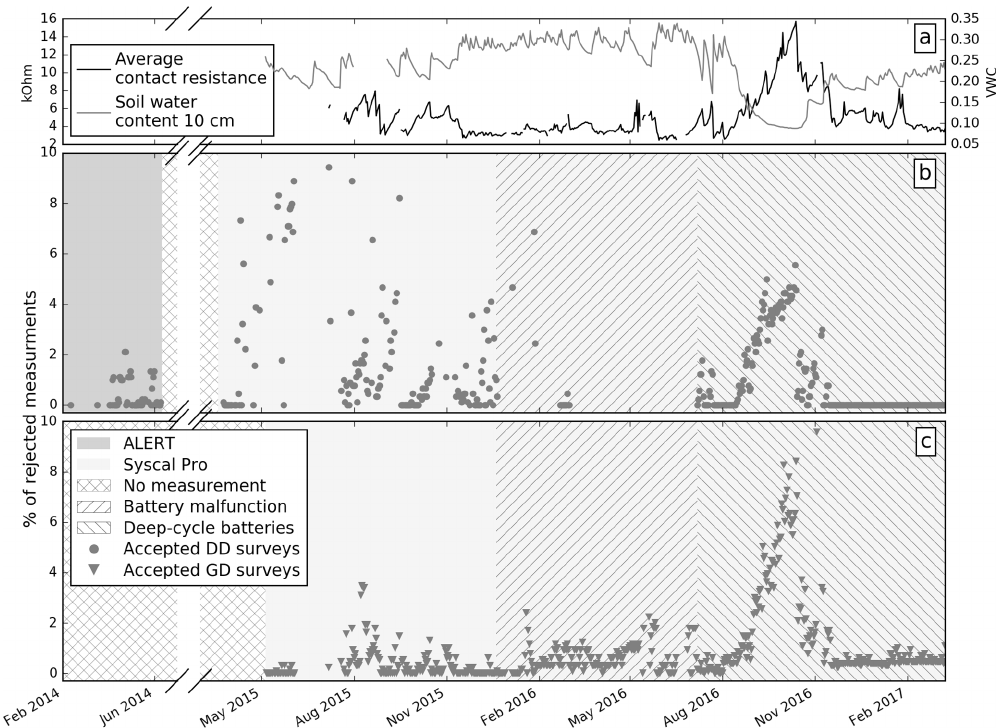
Figure 4. (a) Evolution of the contact resistances averaged along the ERT profile and the soil water content of the 10cm probe (see point 2.6). (b) DD surveys used for the study, after filtering of the available data sets. Each data set with more than 10% of rejected data (less than 810 accepted reciprocal measurements) was removed. (c) GD surveys used for the study, after filtering of the available data sets. Each data set with more than 10% of data rejected (less than 1180 accepted measurements) was removed. Note the break in the x axis between June 2014 and March 2015 where no measurements were acquired. Malfunction of the battery recharge caused most of the DD available data sets to be rejected between mid-December 2015 and the end of June 2016. The drying period in August and September 2016 also lead to a greater number of rejected data. The lower maximum measurement per survey after August 2016 is due to bad contact of electrode